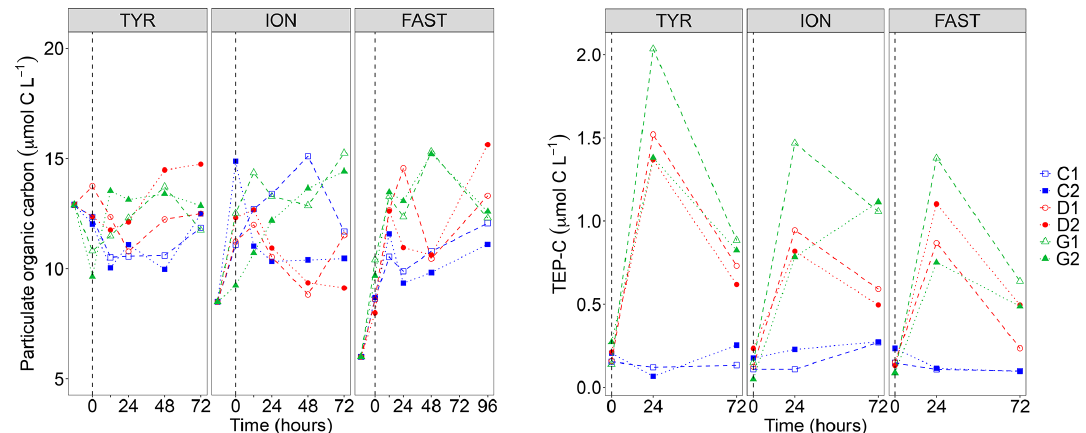
Figure 3. Particulate organic carbon (POC) concentrations and transparent exopolymer particle carbon content (TEP-C) measured in the six tanks (controls: C1, C2; dust addition under present conditions of temperature and pH: D1, D2; dust addition under future conditions of temperature and pH: G1 and G2) during the three experiments (TYR, ION and FAST). The dashed vertical line indicates the time of seeding (after t